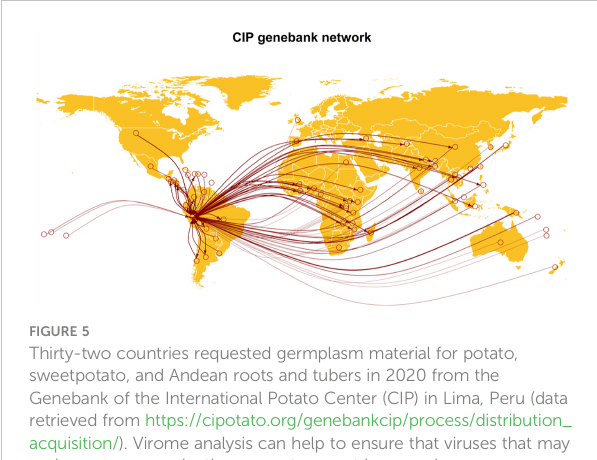
FIGURE 5 Thirty-two countries requested germplasm material for potato, sweetpotato, and Andean roots and tubers in 2020 from the Genebank of the International Potato Center (CIP) in Lima, Peru (data retrieved from https://cipotato.org/genebankcip/process/distribution_ acquisition/). Virome analysis can help to ensure that viruses that may endanger crop production are not present in